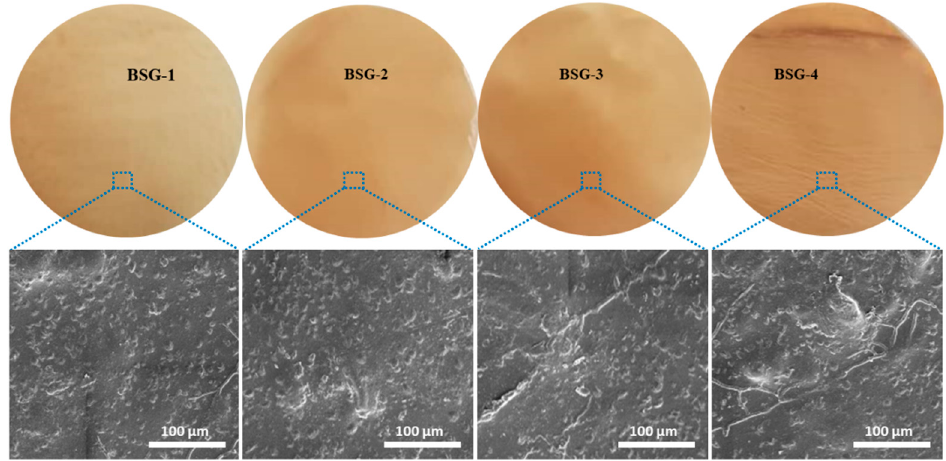
Figure 2. The surface morphology of the hydrogels via SEM.